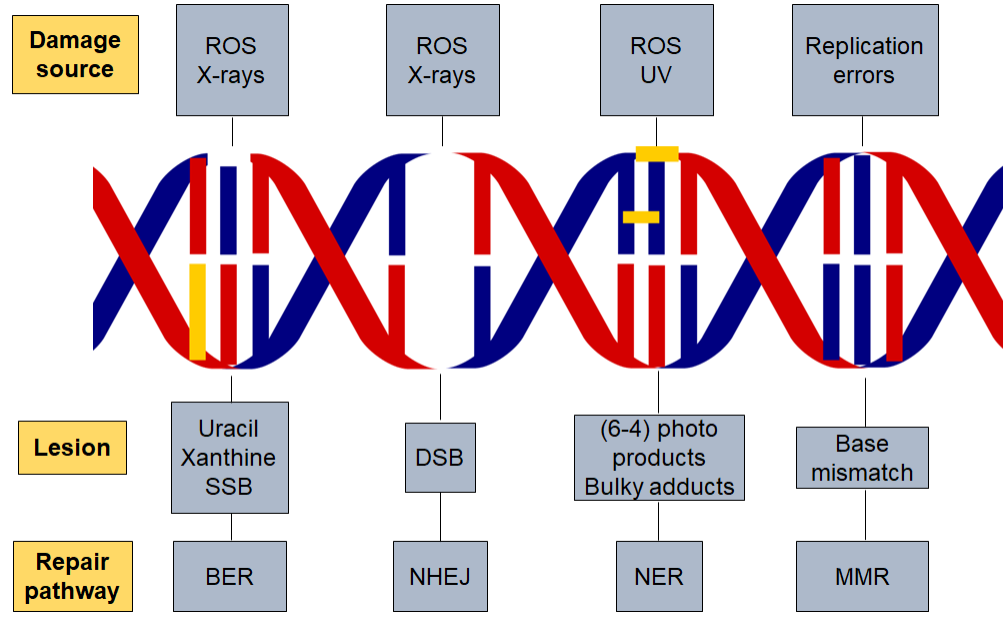
Figure 1. DNA damage and repair pathways. Different factors are responsible for initiating DNA damage such as radiation and reactive oxygen species which cause several types of lesions in the DNA double helix. The repair pathway involved in the process is dependent on the damaging agent and lesion generated. Base excision repair (BER), nucleotide excision repair (NER), non-homologous end joining (NHEJ), reactive oxygen species (ROS) and DNA mismatch repair (MMR).